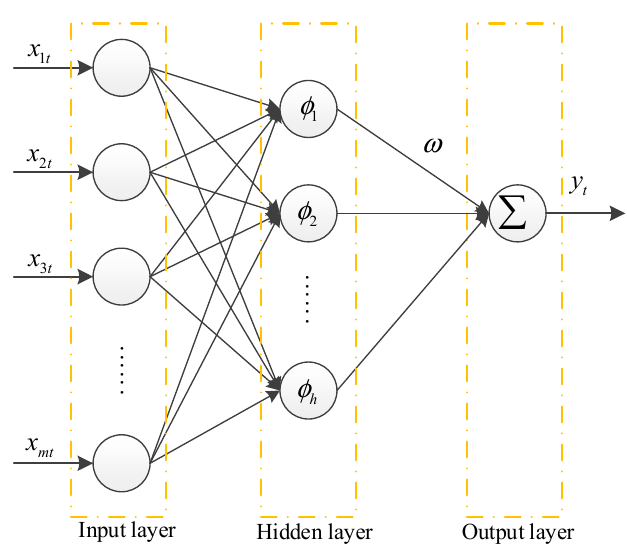
Figure 3. The general structure of RBF.